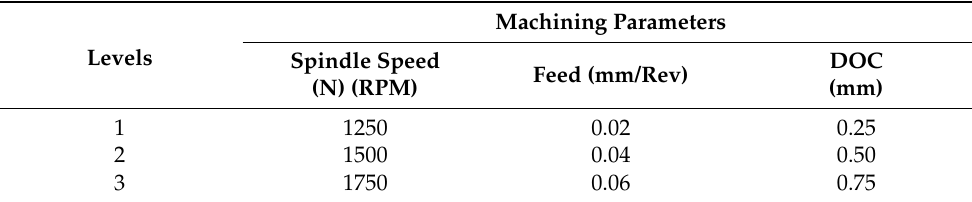
Table 3. Identifying process parameters and their corresponding levels.